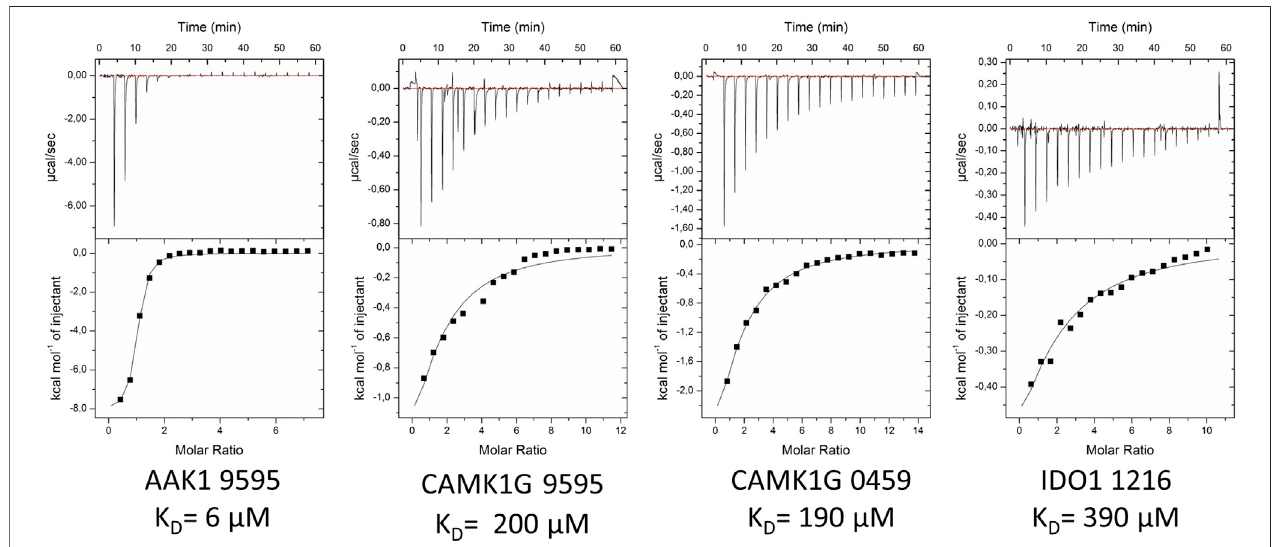
FIGURE 6 | Exempli fi ed ITC thermograms of four validated hits from the STD-NMR with at least one validated fragment per target. K D -values were estimated on duplicates. Standard deviation for measurements was below 15%.